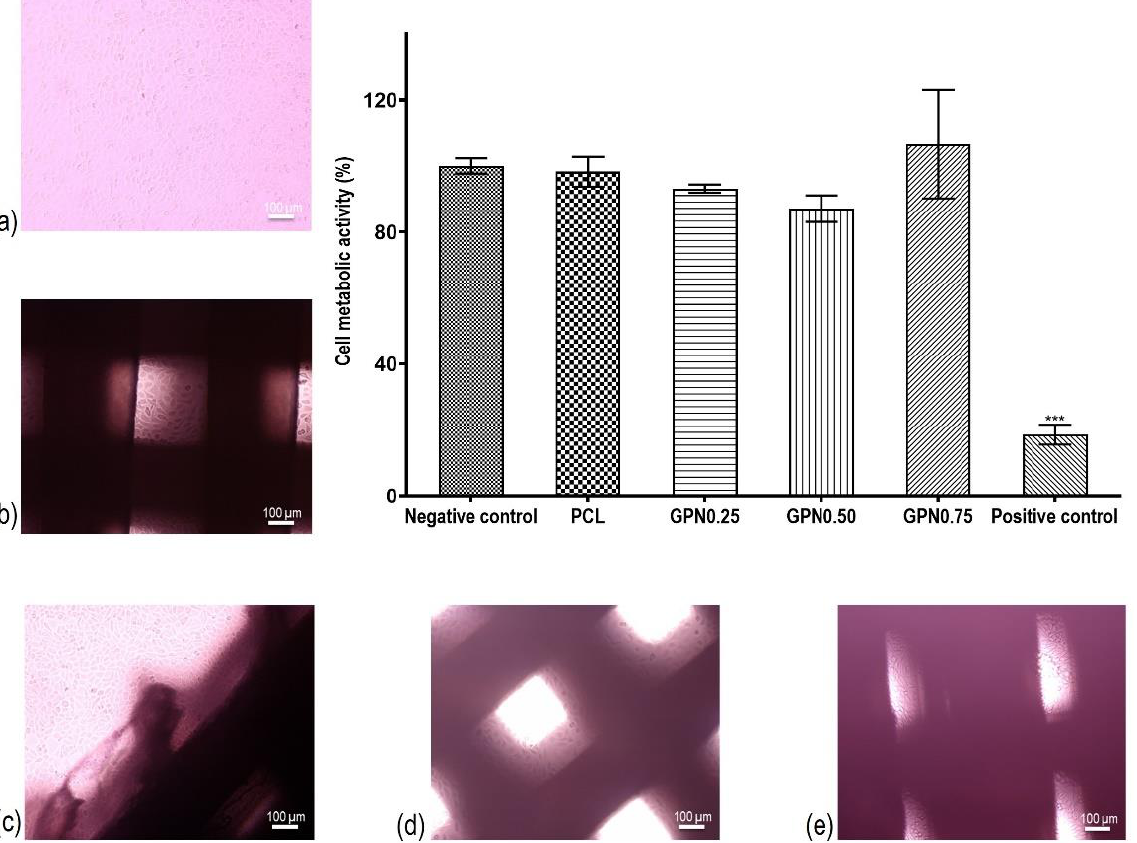
Figure 5. Biological in vitro testing of scaffolds: ( b ) PCL; ( c ) GPN0.25; ( d ) GPN0.50; ( e ) GPN0.75) with L929 cells; cytotoxicity assay according to ISO 10993-5 guidelines direct and indirect extract tests. The percentages of cell viability of the material extracts were normalized to the negative control ( a ) L929 fibroblasts in standard culture medium. The positive control used was latex for cytotoxic effects. Statistical differences: *** p < 0.001.